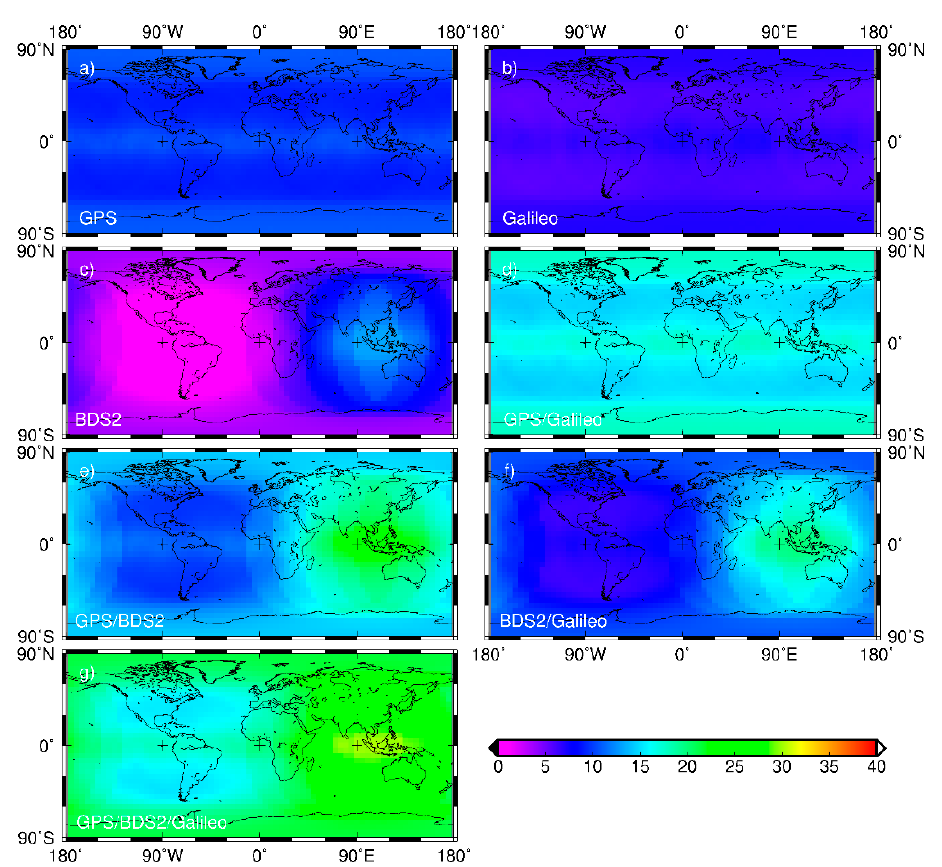
Figure 8. Global distribution of the visible satellite number for seven different constellation Figure8. Globaldistributionofthevisiblesatellitenumberforsevendi ff erentconstellationcombinations combinations on DOY 321, 2018. on DOY 321,